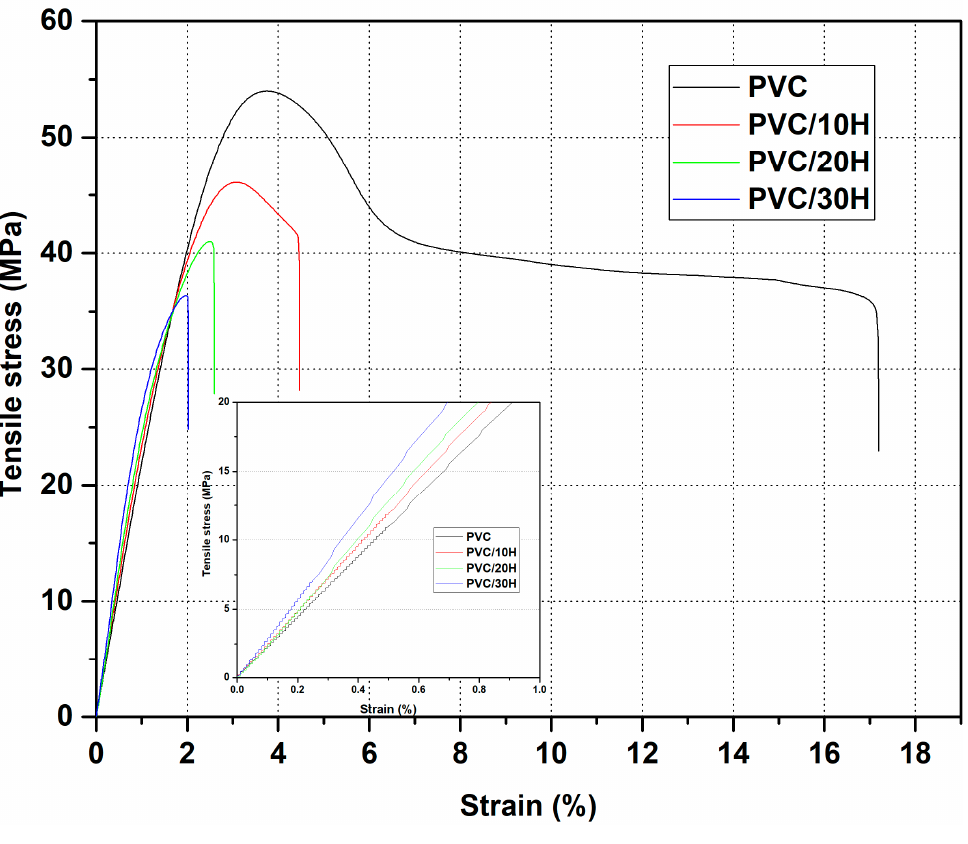
Figure 8. Representative stress–strain curves from the tensile test for the PVC composites.